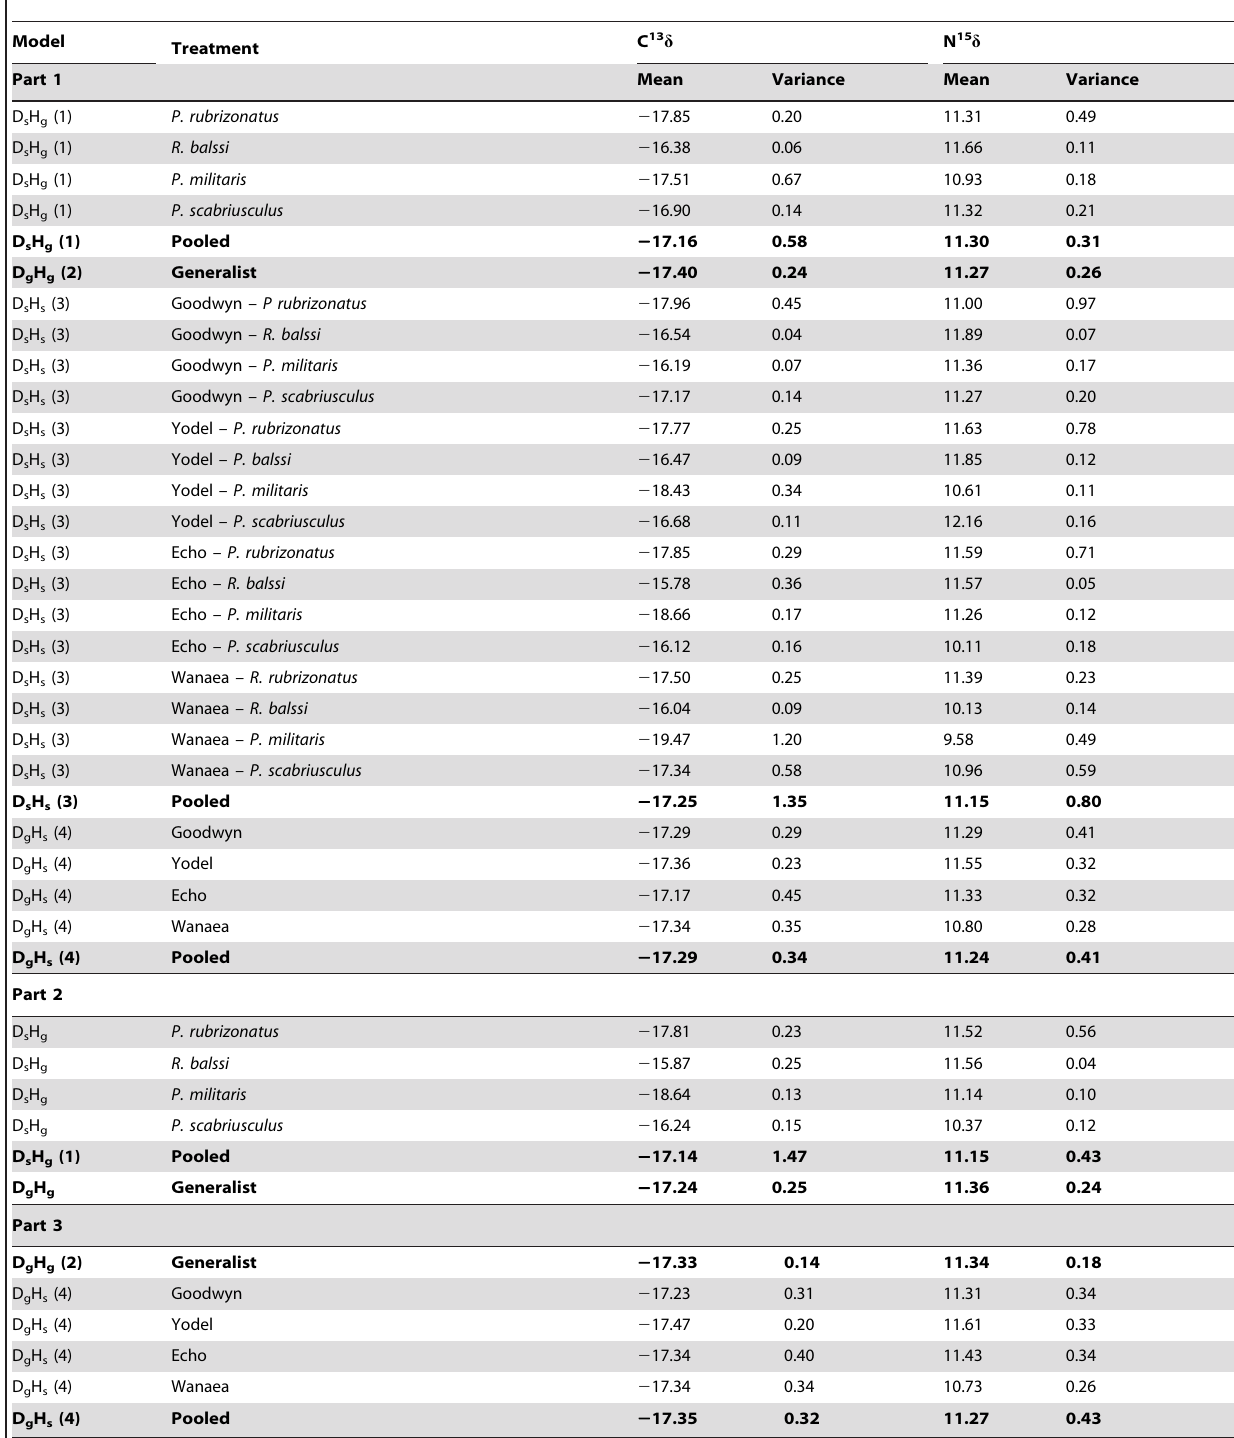
Table 3. Mean and variance of d 13 C and d 15 N for models of simulated Almaco Jack populations.